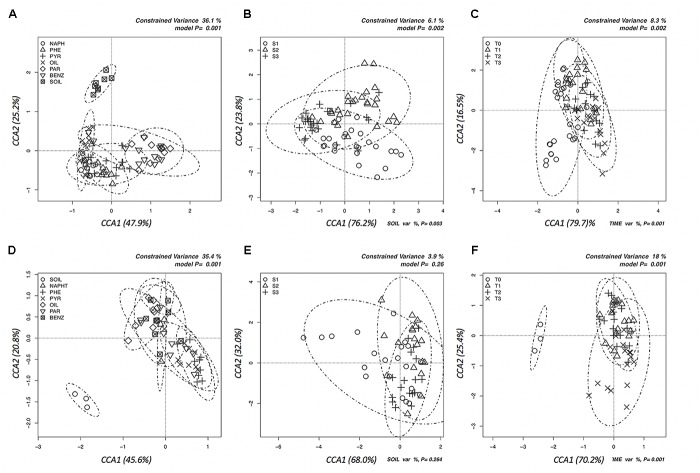
Canonical correspondence analyses (CCAs) to test the significance of the effects of pollutant (A,D), soil depth (B,E), and time (C,F) on the total structure of bacterial and fungal communities as determined by the relative abundances of all the OTUs resulting by Illumina sequencing of bacterial 16S and fungal ITS amplicons. (A–C) Graphs in the first line are for bacteria, (D–F) are for fungi.